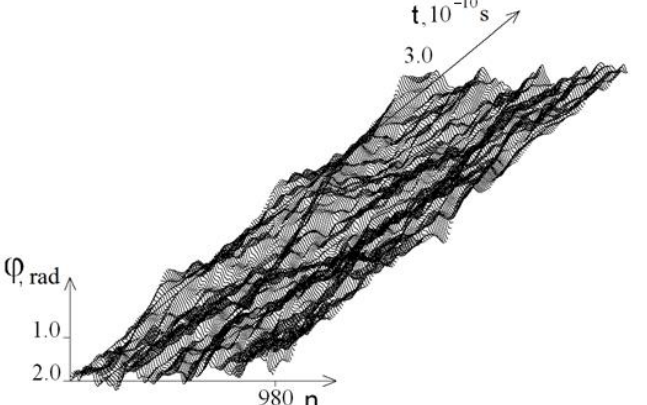
Figure 3. Graphs of angular deviations of the first strand of the DNA molecule at M 0 = 13.172 on the time interval [2 T 0 , 3 T 0 ].